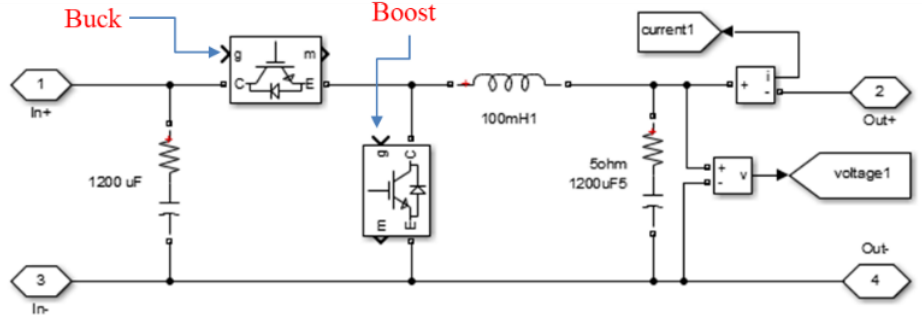
Figure A3. Bidirectional DC/DC converter.